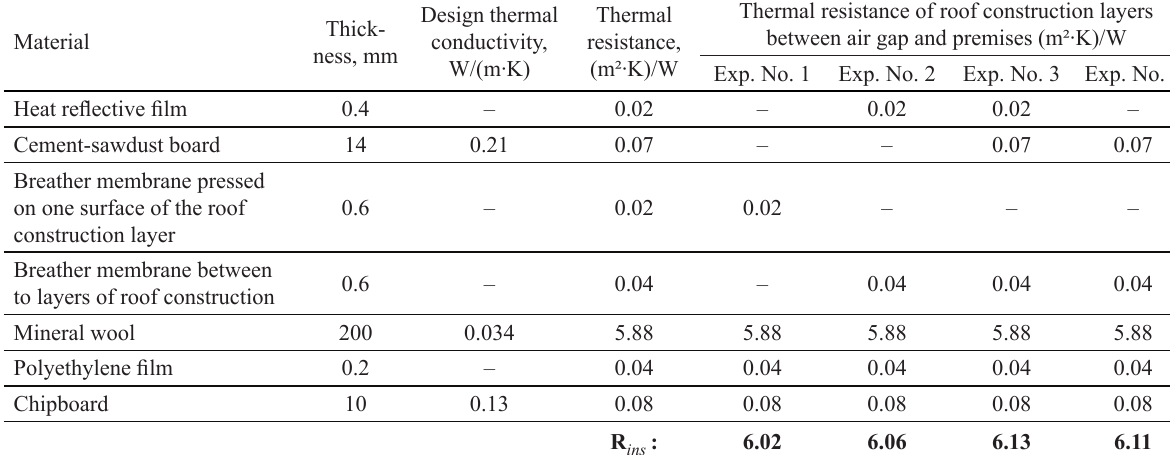
table 2. thermal-technical indicators of the roof between the ventilated air gap and premises